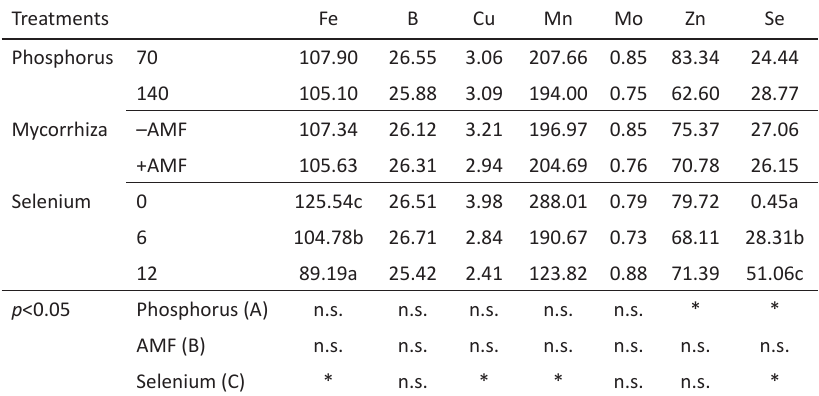
Table 4. Effect of mycorrhiza on content of micronutrients and selenium (mg kg -1 d.m.) in lettuce grown on medium with different levels of phosphorus and selenium (mg dm -3